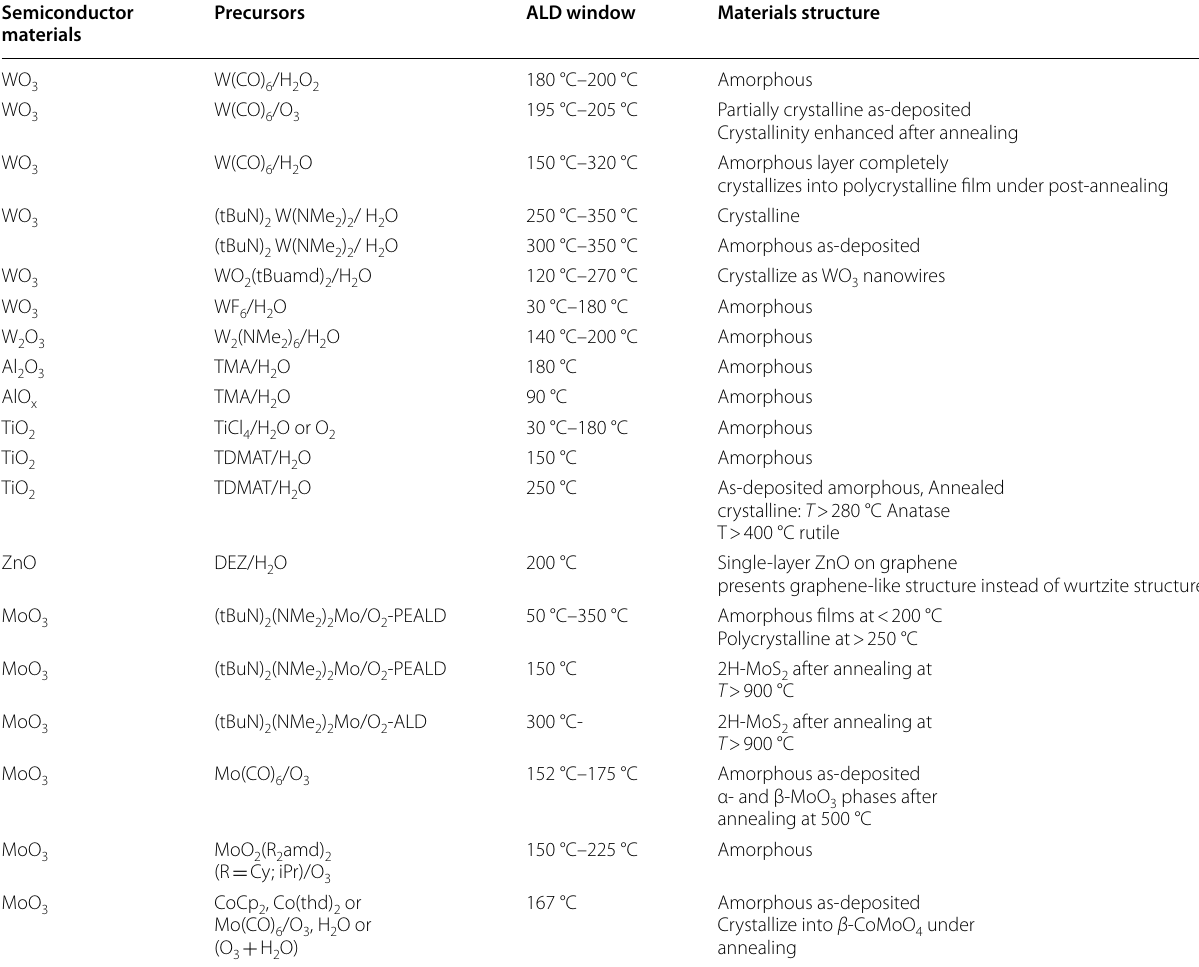
Table 3 Review of the reported ALD deposition of ultra-thin 2D metal oxide films. Reprinted with permission from [94] Semiconductor